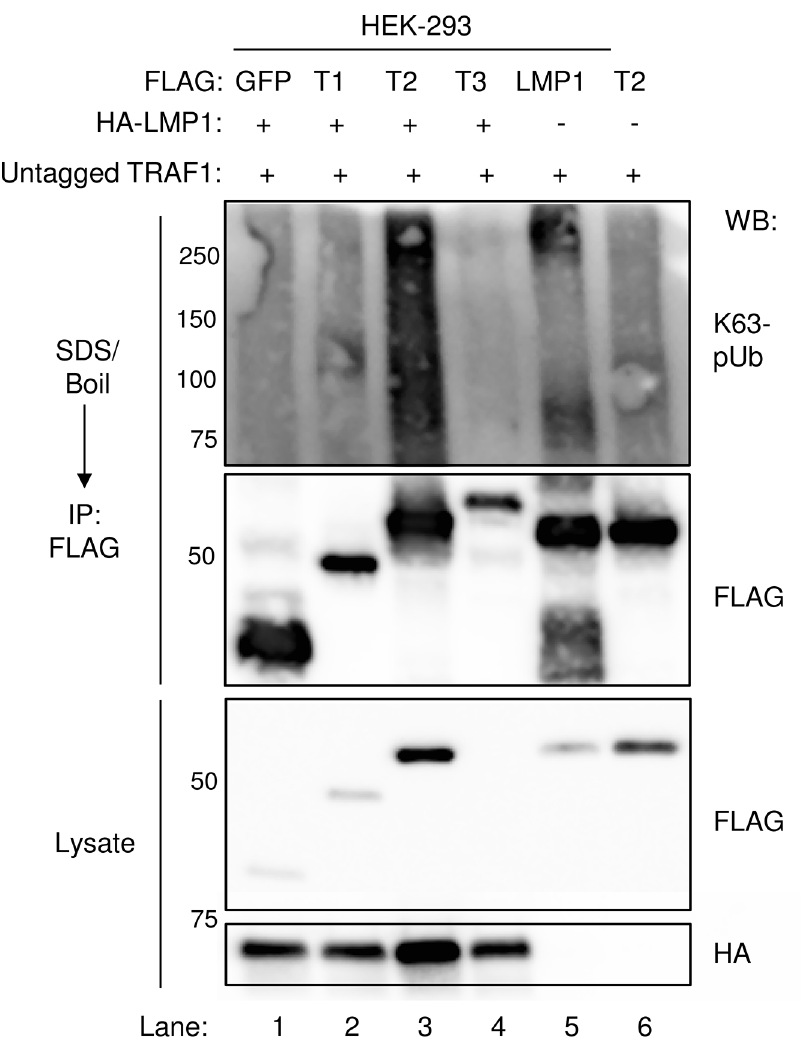
Fig 10. LMP1 1 – 231 expression induces K63-pUb chain attachment to TRAF2. 293 cells were co- transfected with FLAG-tagged GFP, TRAF1 (T1), TRAF2 (T2), TRAF3 (T3), or LMP1 constructs, HA-LMP1, and untagged TRAF1 for 24 hours, as indicated. 1% SDS was added to whole cell lysates, and samples were boiled for 5 minutes to denature complexes. SDS was diluted to 0.1%, and anti-FLAG IP was performed. Western blots were performed, as indicated. A-D are representative of three independent